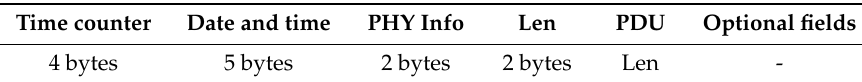
Table 4. Traffic capture interface protocol. Payload format. Physical layer (PHY); packet data unit: PDU.